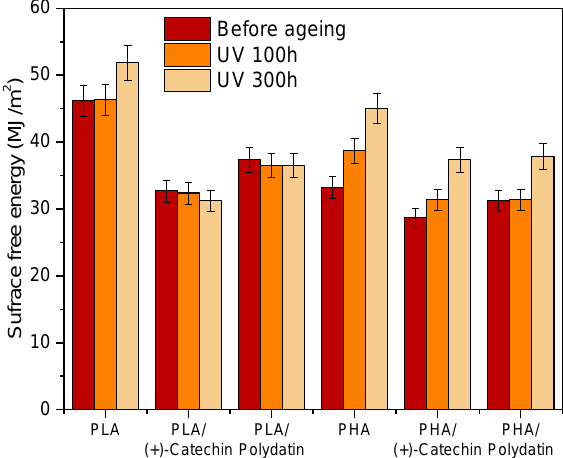
Figure 8. Surface free energy of PLA and PHA samples before and after aging.